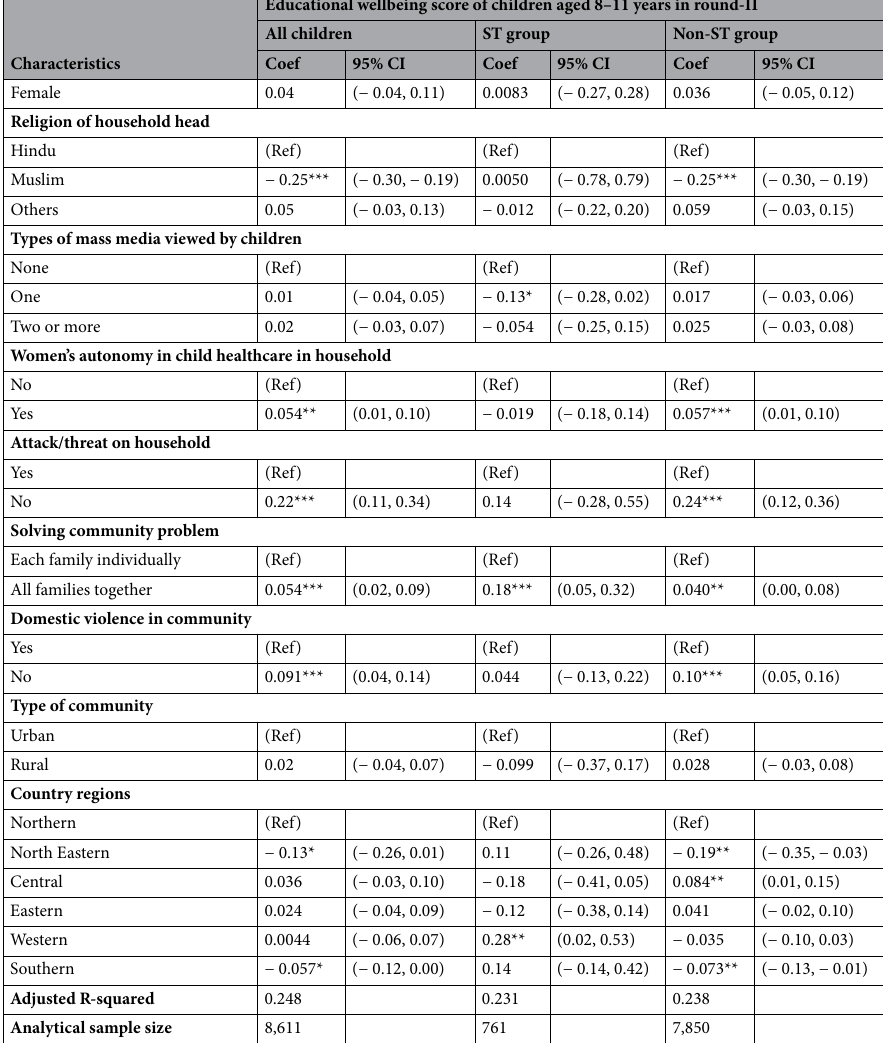
Table 2. Linear regression models showing the multivariate association between educational wellbeing score and the individual, household and community characteristics of the panel of children aged 1–4 years during